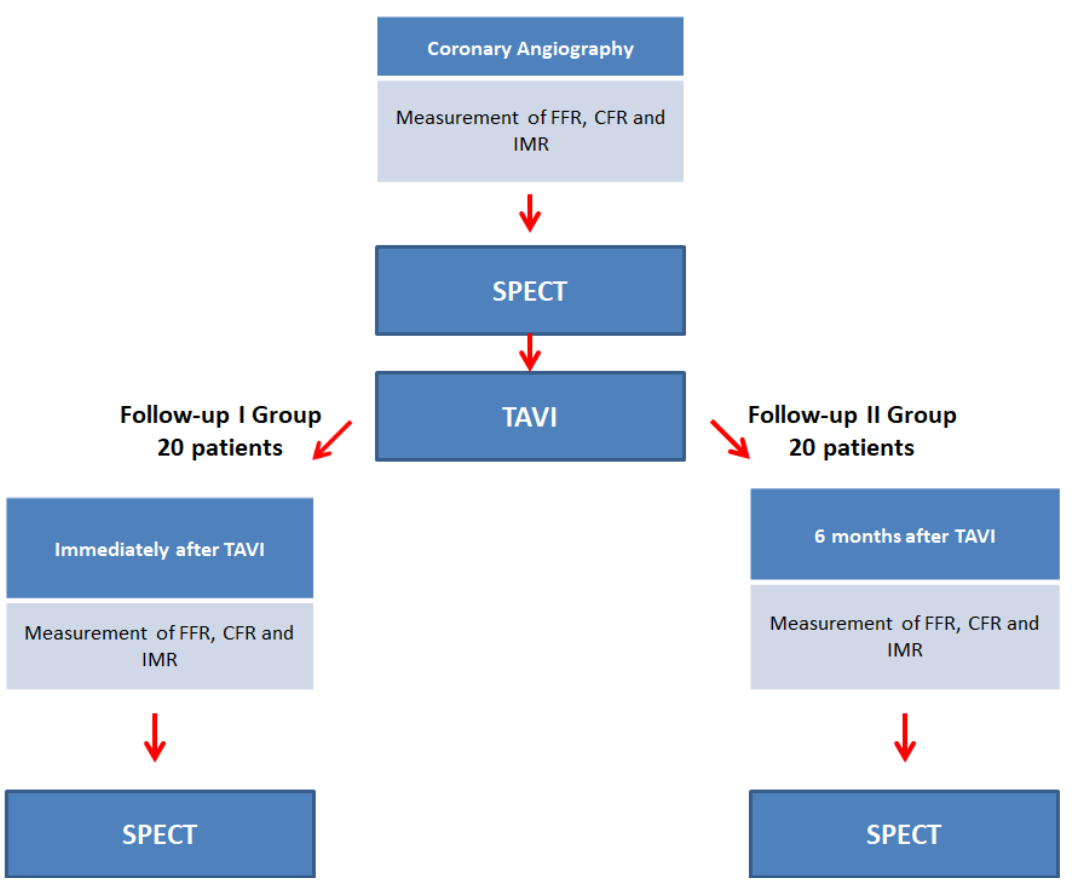
Figure 1. Study design and first endpoint.